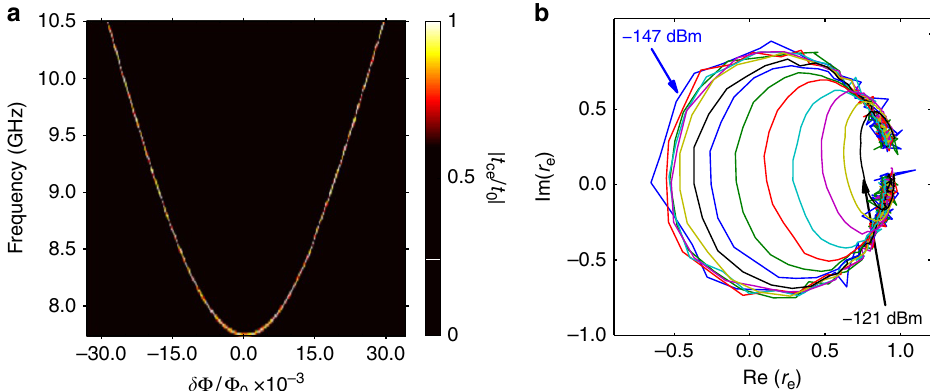
Figure 2 | Response of the system to the continuos microwaves. ( a ) Transmission spectrum through the artificial atom. The normalized transmission amplitude | t ce / t 0 | from the control line to the emission line versus flux bias d F , measured from half-flux quantum F 0 /2, where the energy is minimal. The transmission is suppressed everywhere except at the resonance frequencies of the atom. At the resonance frequency, the atom, excited from the control line, reemits the radiation to the emission line. ( b ) Reflection coefficient r e in the emission line around d F ¼ 0 (the minimal atomic energy) on a complex plane. Reflection coefficient r e is plotted in real-imaginary coordinates for probing powers from (cid:2) 147 to (cid:2) 121dBm with a step of 2dB. NATURE COMMUNICATIONS|7:12588|DOI: